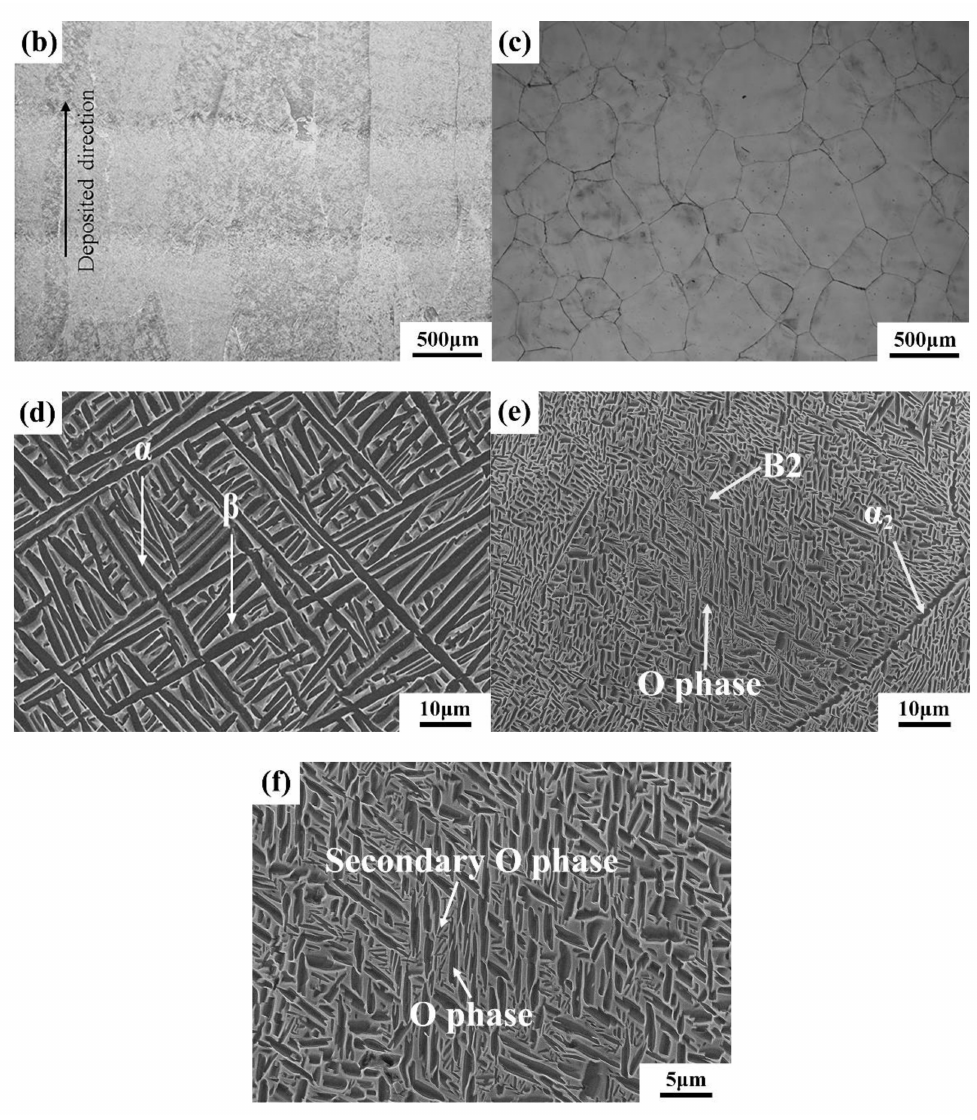
Figure 9. Microstructure of TA15 / Ti 2 AlNb dual alloy: ( a ) the macromorphology of the microstructural distribution in the TA15 / Ti 2 AlNb dual alloy; ( b ) the morphology of the prior β grains in the TA15 side; ( c ) the morphology of prior β grains in the Ti 2 AlNb side; ( d ) the microstructure in the β grains of TA15; ( e ) the microstructure in the β grains of Ti 2 AlNb; ( f ) highly magnified microstructure in the β grains of Ti 2